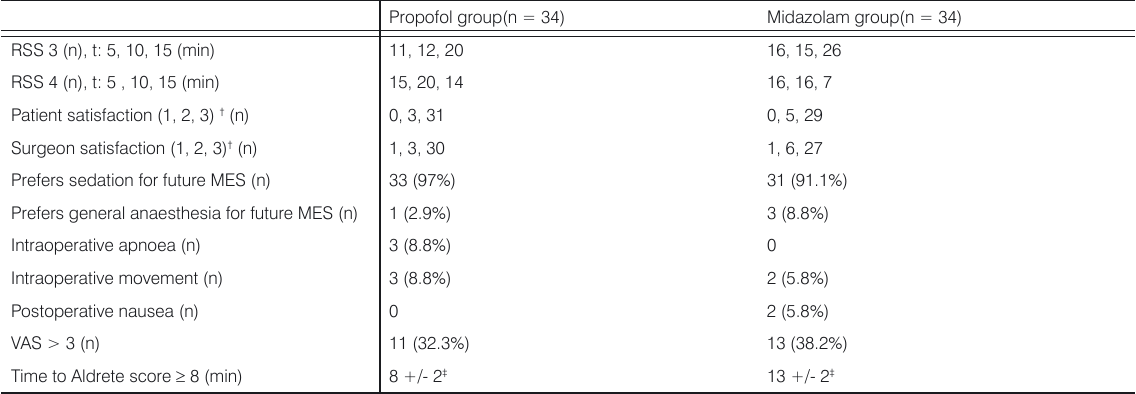
Table 4. Intraoperative and postoperative